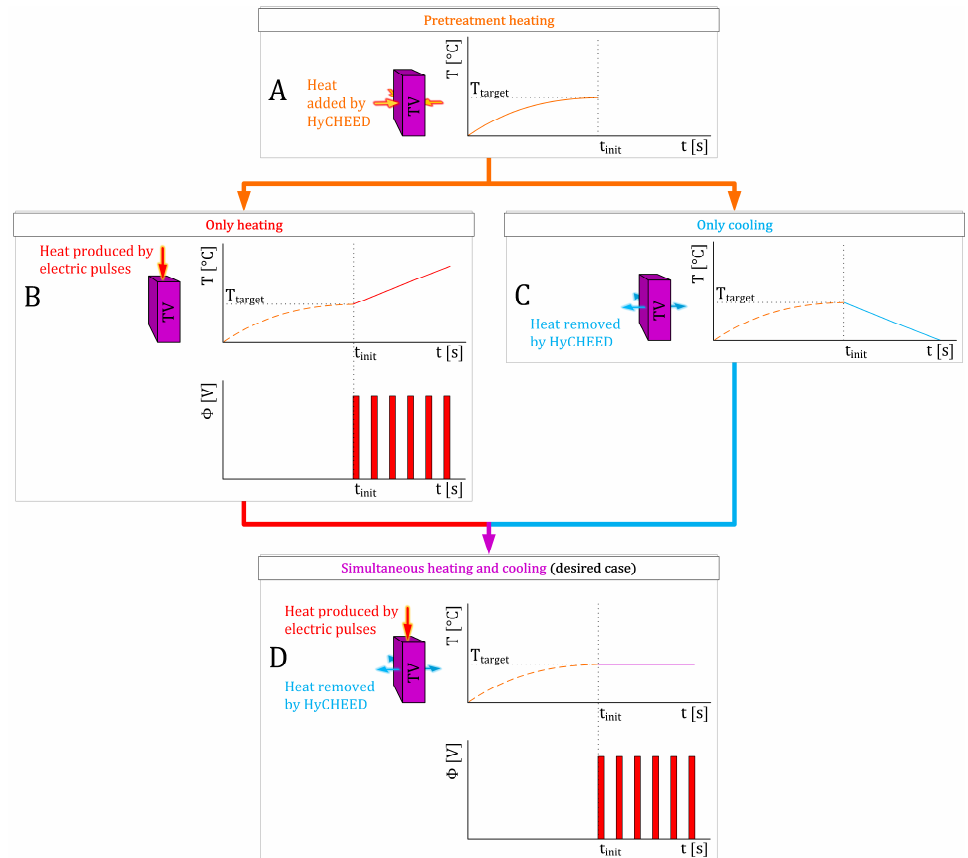
Figure 1. Schematic illustration of the temperature control mechanism of the hydraulically controllable heat exchange electroporation device (HyCHEED). ( A ) The left side illustrates a target volume (TV) represented by a purple cuboid that is heated up by HyCHEED up to the target temperature (T target [°C]) prior to the initial time (t init [s]) at which IRE starts; the heat is represented by orange arrows. The right side shows the temperature (T [°C]) of the TV as a function of time (t [s]). Please note that the black dotted lines represent T target and t init . After achieving T target for ( B – D ), three situations were presented: Situation 1 ( B ) illustrates the TV in which the heat is generated at t init due to a series of electric pulses with voltage (Φ [V]) in the TV when neglecting any cooling effects; the produced heat due to the electric pulses is represented by a red arrow. Situation 2 ( C ) illustrates the TV from which heat is removed by HyCHEED when neglecting heating by the electric pulses; the heat removal is represented by blue arrows. Situation 3 ( D ; the desired case) illustrates the TV in which a balance is achieved between heat generation due to electric pulses and heat removal by HyCHEED.